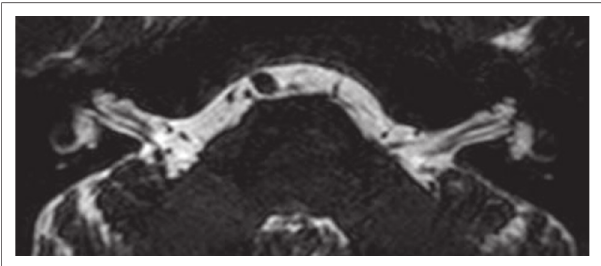
FIGURE 2: Axial 3D T2 of the cerebellopontine angle, showing the typical corkscrew appearance of the anomalous cochlea. The cochlear nerve is present.